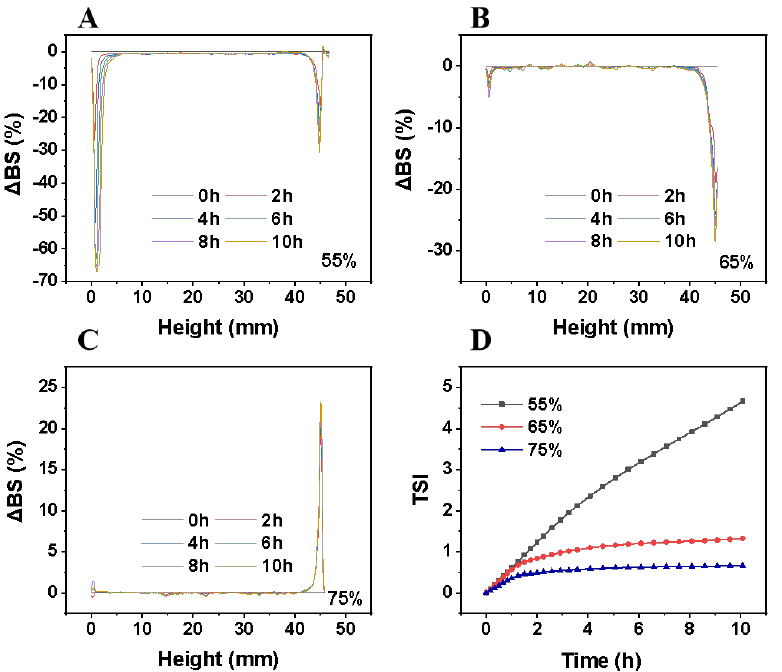
Figure 9. The backscattered light (ΔBS) of emulsions stabilized by Z3S1 with different oil phase volume fractions, φ = 55% ( A ), φ = 65% ( B ), φ = 75% ( C ). TSI value of emulsions stabilized by Z3S1 volume fractions, ϕ = 55% ( A ), ϕ = 65% ( B ), ϕ = 75% ( C ). TSI value of emulsions stabilized by Z3S1 with different oil fractions ( D ). with different oil fractions ( D